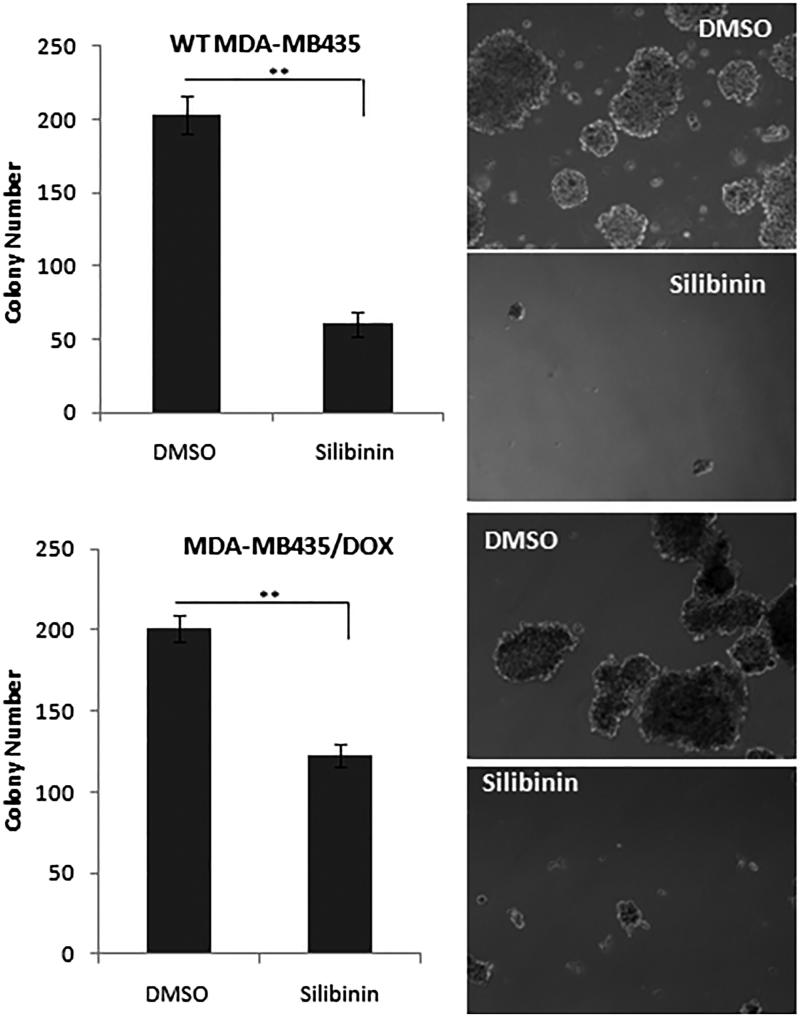
The effects of silibinin on tumorigenicity of MDA-MB-435. MDA-MB435/WT and MDA-MB435/DOX cells were treated with silibinin for 48 h then they are detached and subjected to mammosphere assay. The colonies were counted after 7 days. The right panel illustrates the morphology of the colonies (40× magnification).